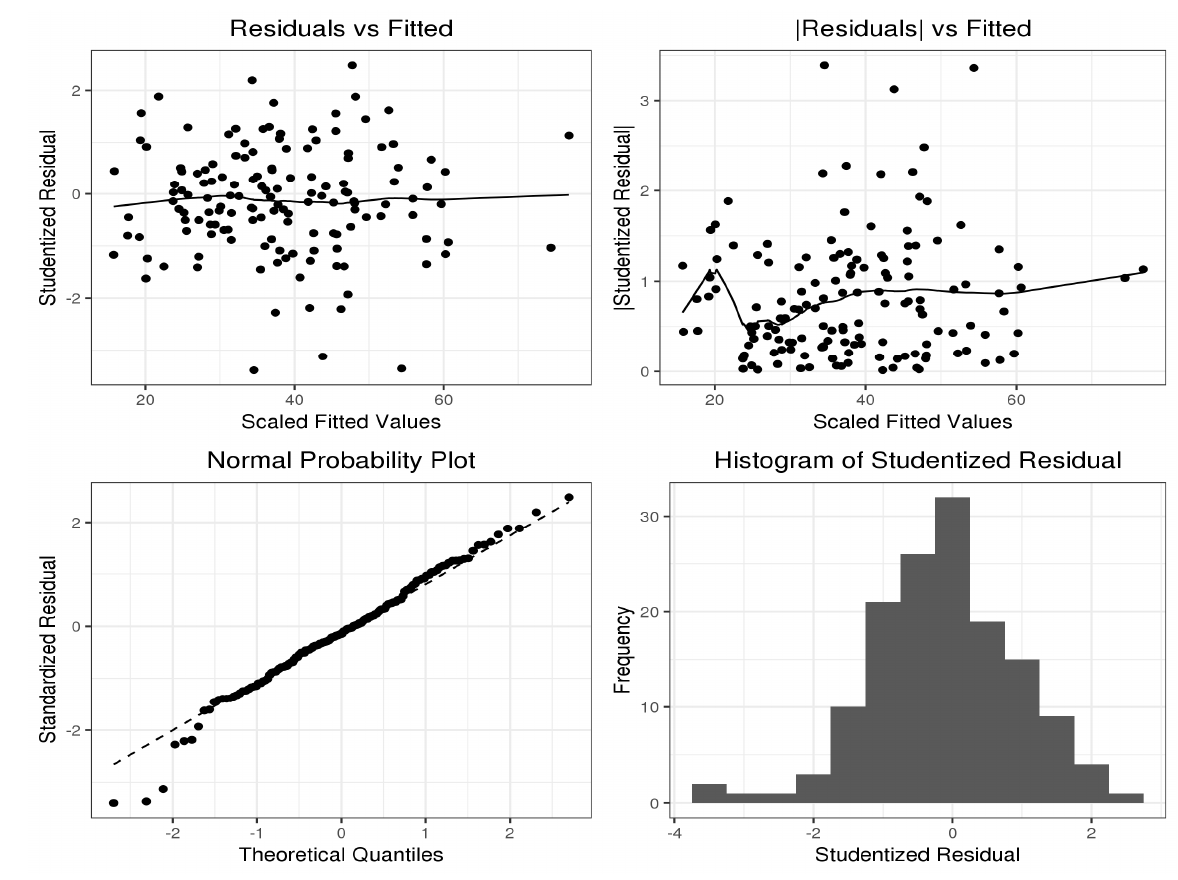
Figure 5. Plot of PM 2 . 5 Gamma model diagnostics.